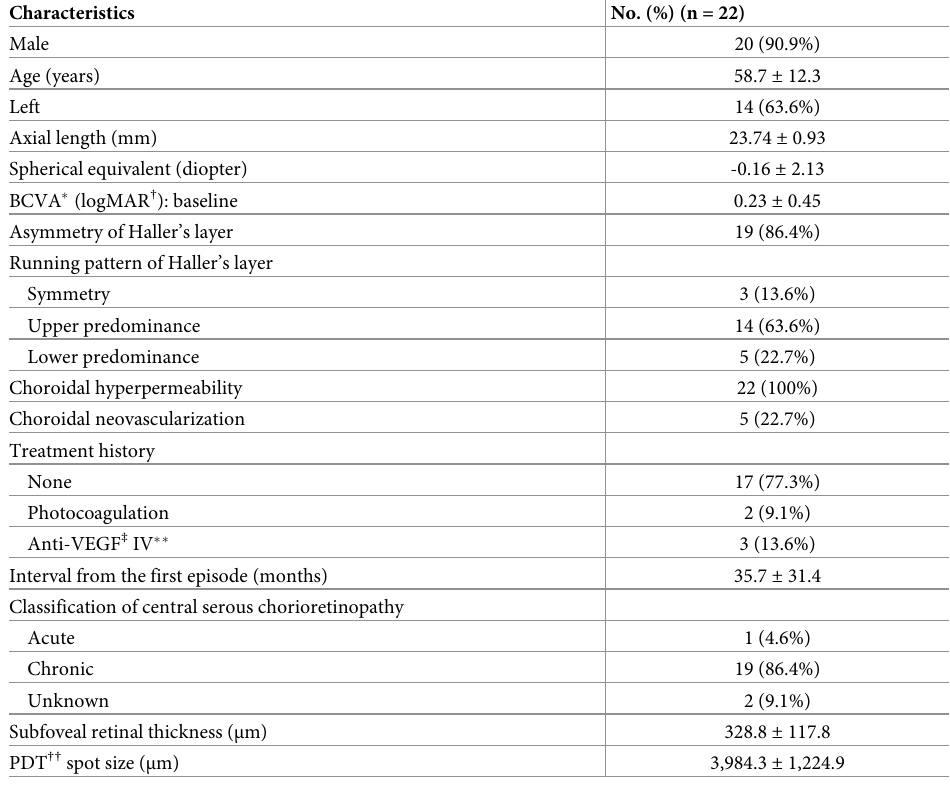
Table 1. Pretreatment characteristics of patients with central serous chorioretinopathy.